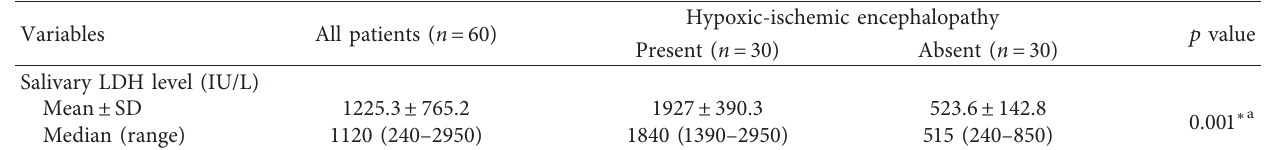
Table 2: Comparison of the salivary LDH level between cases and controls.